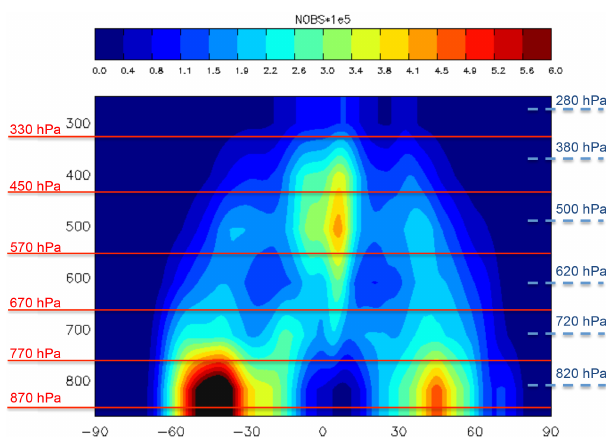
Figure 1. Latitude–height section of annual zonal mean OMI cloud frequencies (CRF > 50%) – observed during daytime around 13:45LST. On the left in red, the bottom pressure boundaries for the calculation of annual mean NO 2 VCDs above cloud (after Table 1). On the right in blue, the approximate pressure for the resulting NO 2 VMR after differentiation of VCDs (also after Table